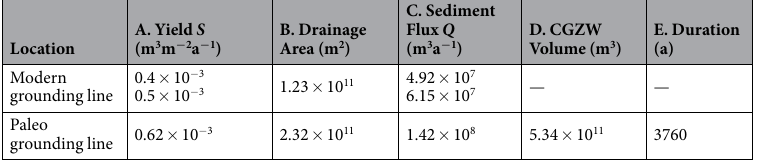
Table 1. (A) Low and high modern Antarctic sediment yield estimates from Alley et al . 19 and paleo sediment yield; (B) Modern and paleo Bindschadler Ice Stream drainage area; (C) Sediment flux for the modern and paleo Bindschadler Ice Stream; (D) CGZW volume calculated in this study; (E) duration of WAIS grounding on the outer continental shelf of the Whales Deep